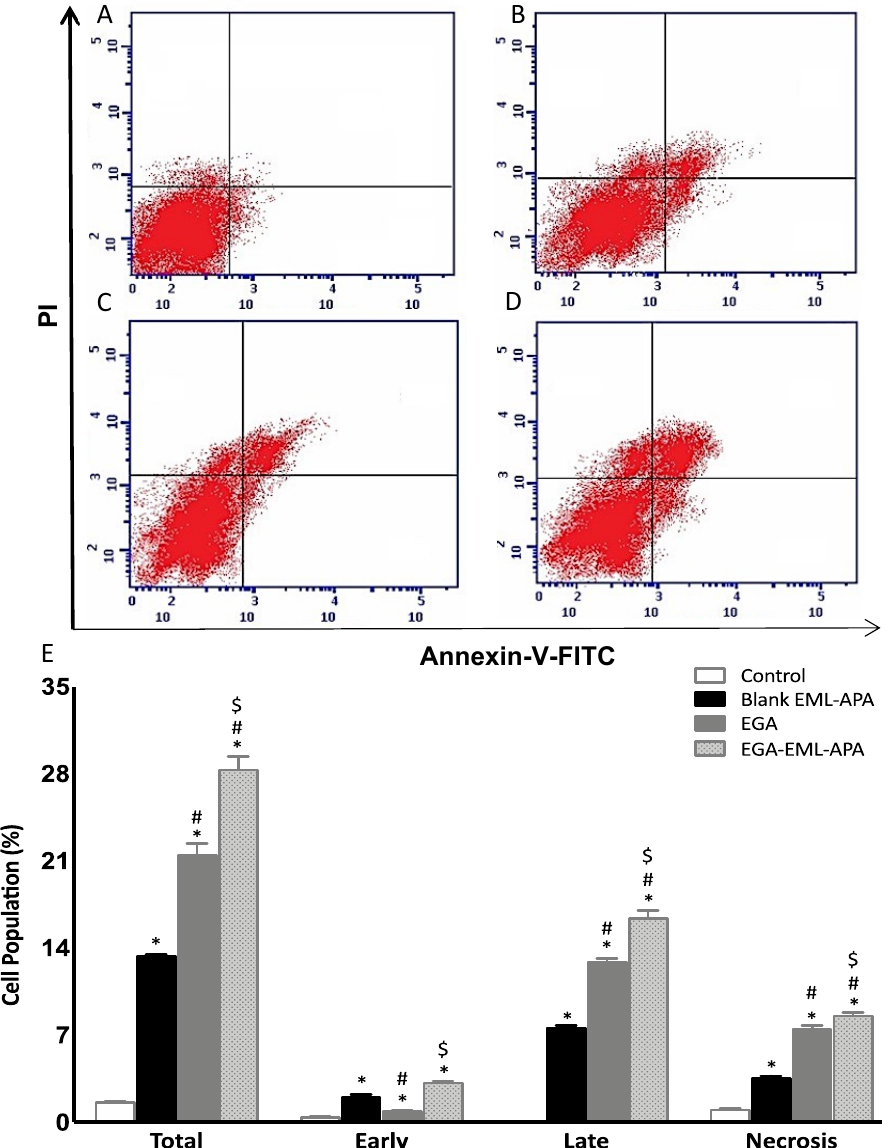
Figure 10. Assessment of apoptosis in MCF-7 control cells ( A ), or treated with blank EML-APA ( B ), EGA ( C ) and EGA-EML-APA ( D ) and the percentages of early and late apoptotic cells ( E ) following annexin V staining. Data are expressed as mean ± SD. * Significantly different from control at p < 0.05, # significantly different from blank EML-APA at p < 0.05, $ significantly different from EGA at p < 0.05. Abbreviations: EGA, ellagic acid; EML, emulsomes; APA, apamin.